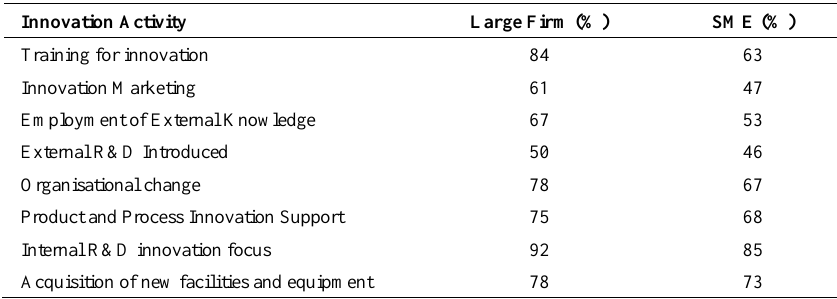
Table 3. Comparison of Innovation Active Prevalence in Korean SMEs